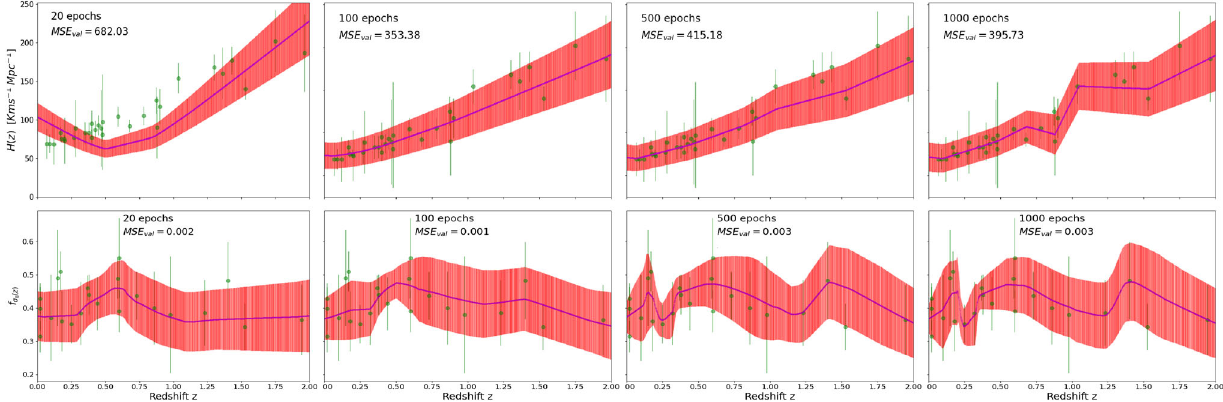
Fig. 7 Reconstructions from Artificial Neural Networks trained with different numbers of epochs. The effect of the epochs can be noticed in training with the CC dataset (top) and with the f σ 8 ( z ) measurements (bottom). The first case (20 epochs) shows underfitting while consid- ering 1000 epochs shows overfitting. In the f σ 8 dataset, the cases for